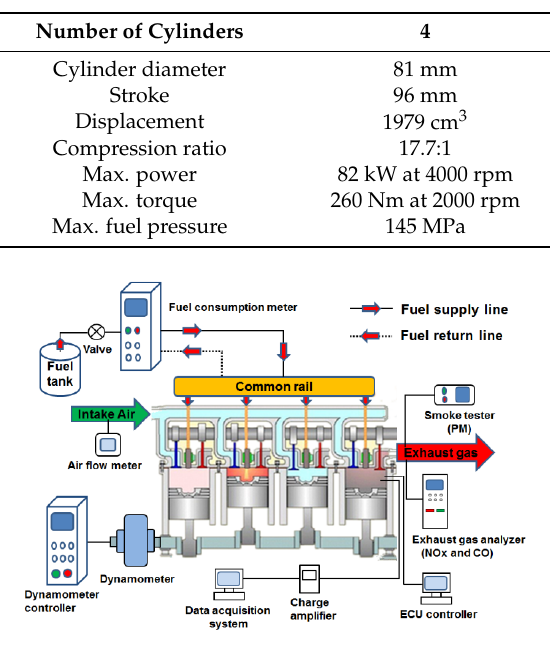
Figure 1. Schematic diagram of the experimental apparatus.